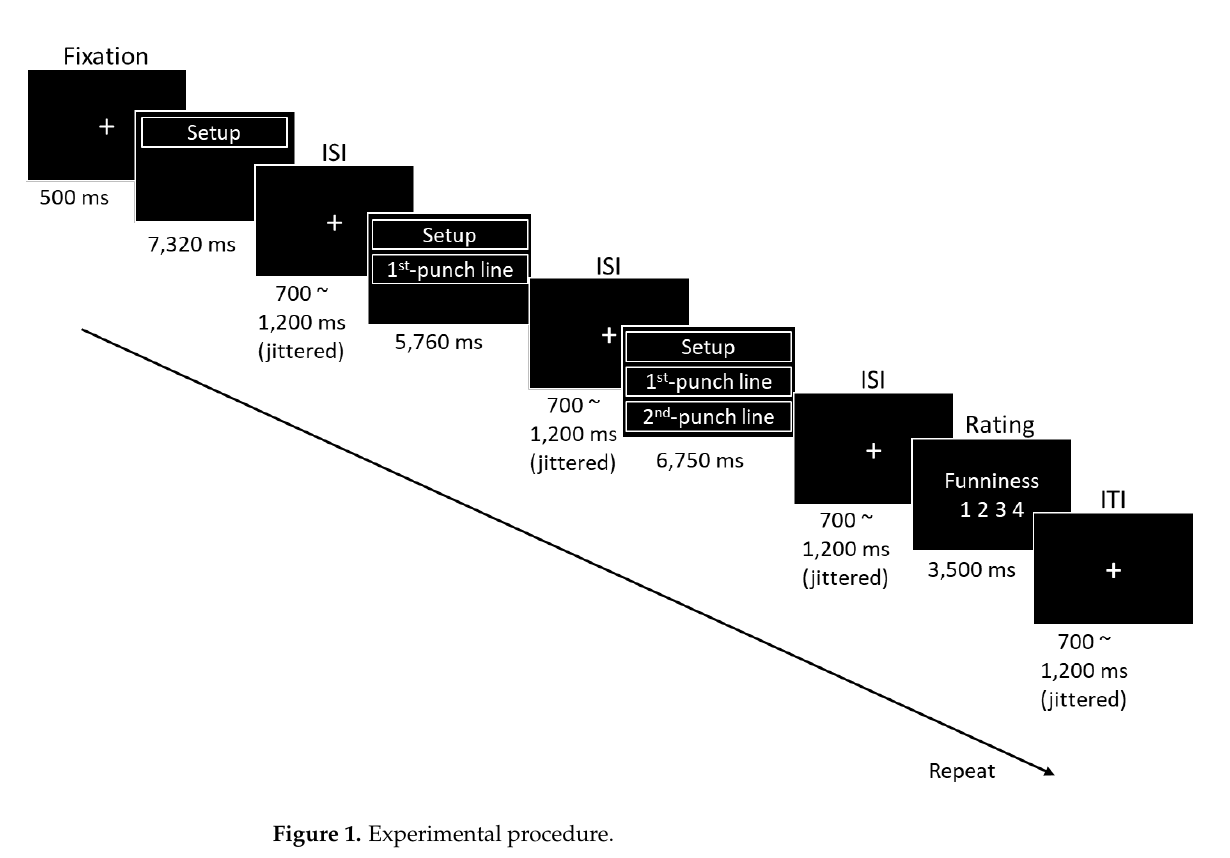
Figure 1. Experimental procedure.